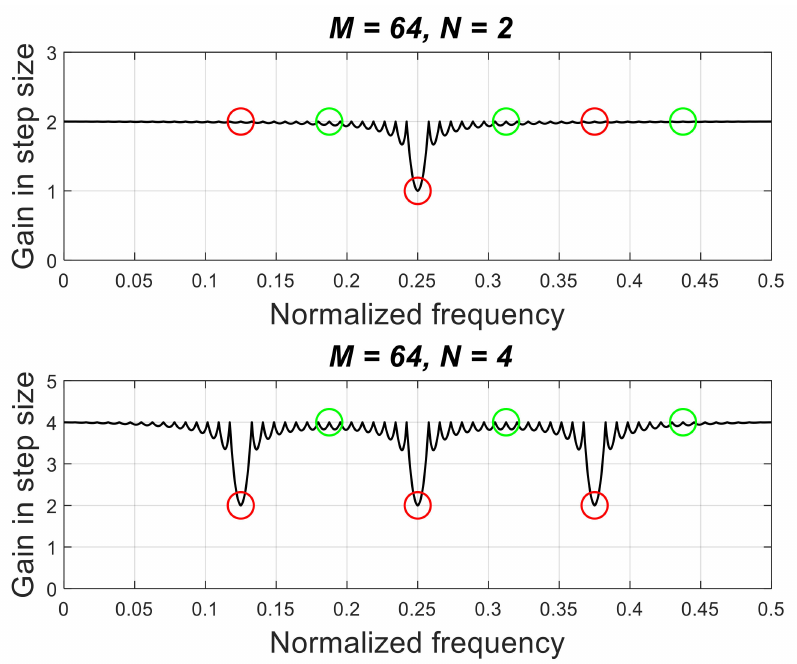
Figure 7. Gain in step-size for a single tone when using sequential PU with LMS algorithm. The length of the filter is set to 64 taps. The decimation factor takes values 2 and 4. Circles mark frequencies where reference and desired signals have significant harmonics; red circles mark components of x 1 ( n ) and green circles mark components of x 2 ( n )